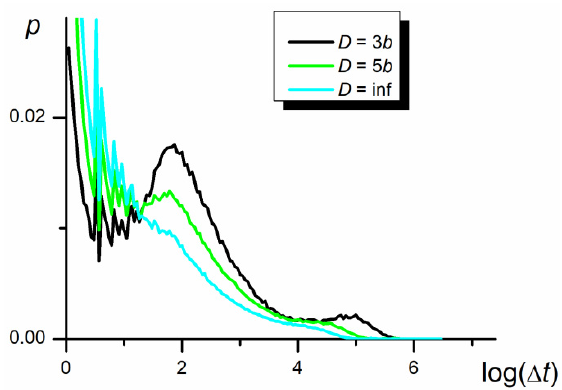
Figure 11. The probability density functions of time periods, ∆ t , between swapping of P1 and P2 mass centers in the nanochannel and in the 3D space in the logarithmic scale at different nanopore width ( N = 100, ε PP / k B T = 0 for P1 and P2).